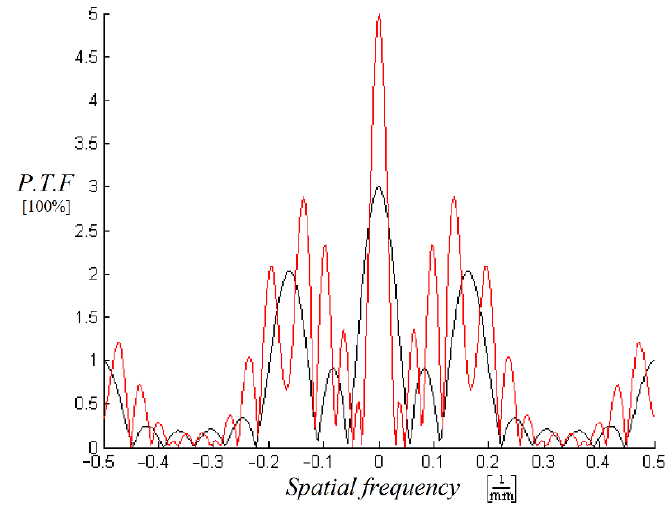
Figure 2. The F ( µ ) filter: Fast Fourier Transform of the Low Pass Filter and the spectral areas with loss of information (zero points in the spectral area). The pinhole array filter with N = 3 (black) and with N = 5 (red).